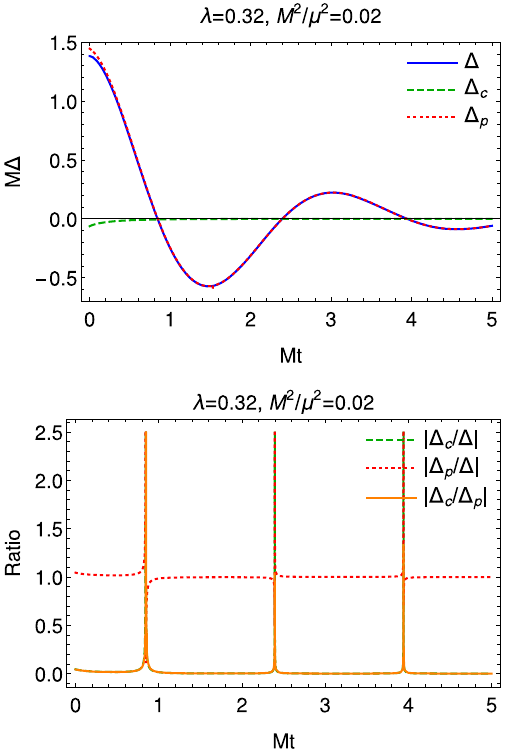
Fig. 25 The same plots for the gluon Schwinger function in the Euclidean region as those in Fig. 18 for the choice of parameters with a smaller mass, λ = 0 . 32, M 2 /μ 2 = 0 .